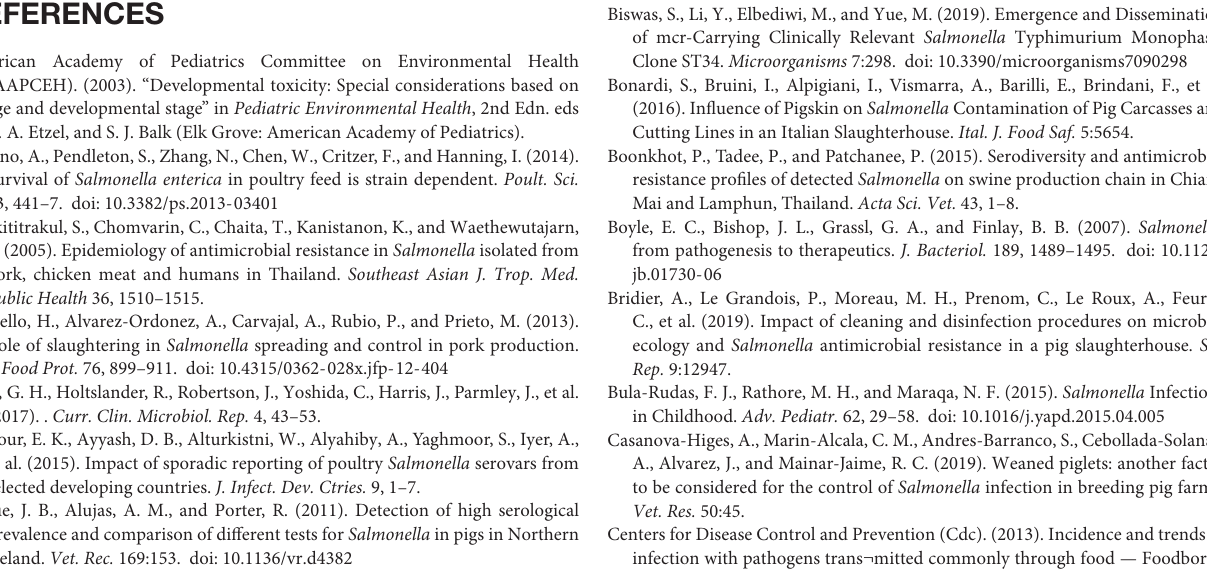
Supplementary Figure 1 | Pie chart of the prevalence of S . Rissen isolates obtained from food of animal-origin samples in